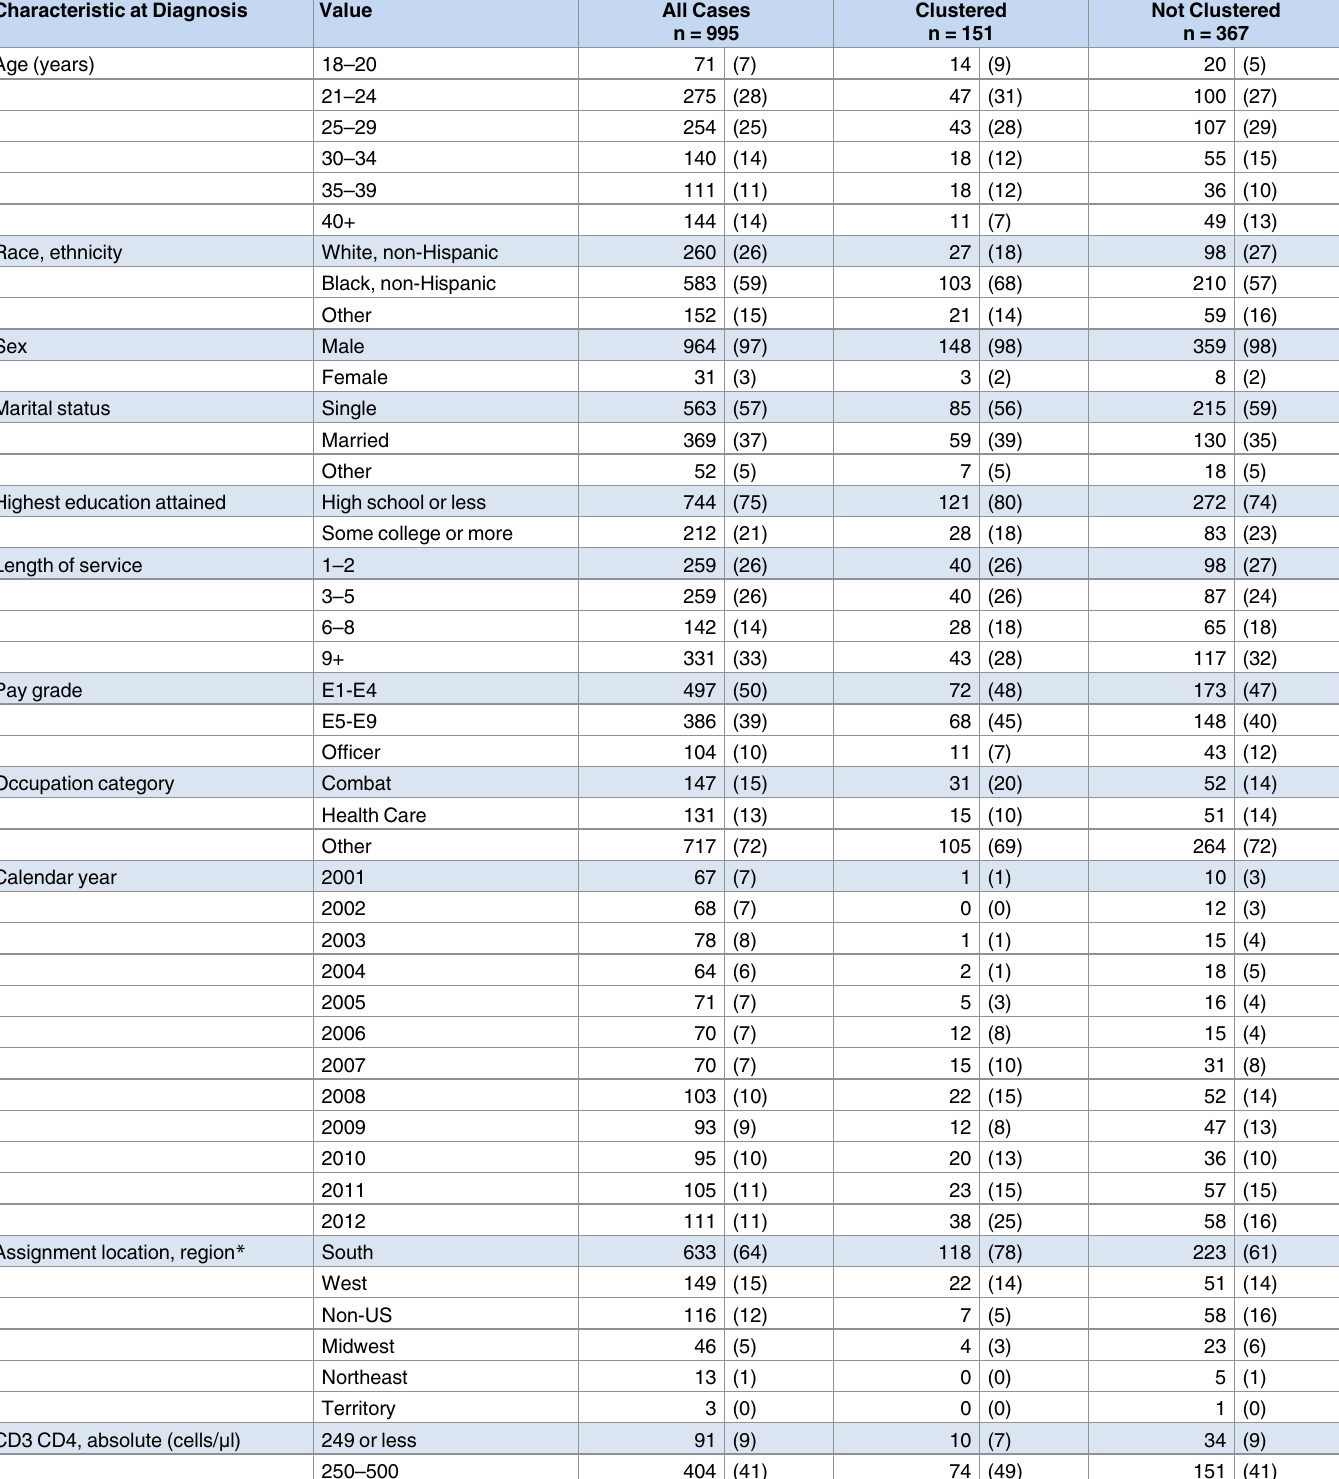
Table 1. Demographic, service-related, and clinical characteristics of 995 HIV-infected Soldiers newly diagnosed from 2001–2012,overall, and by transmission clustering. Characteristic at